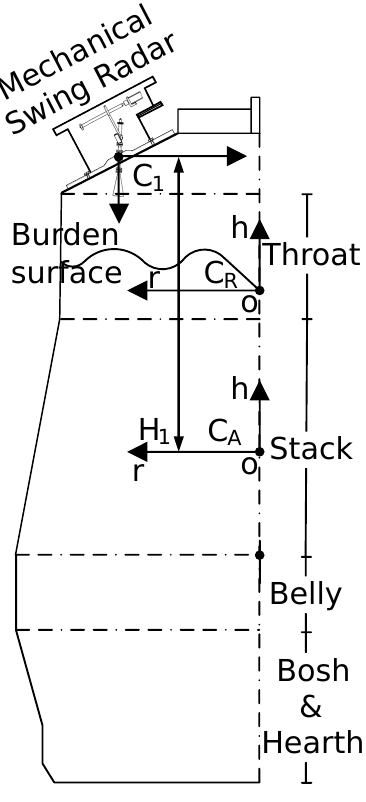
Figure 1. Radar placement on top of the